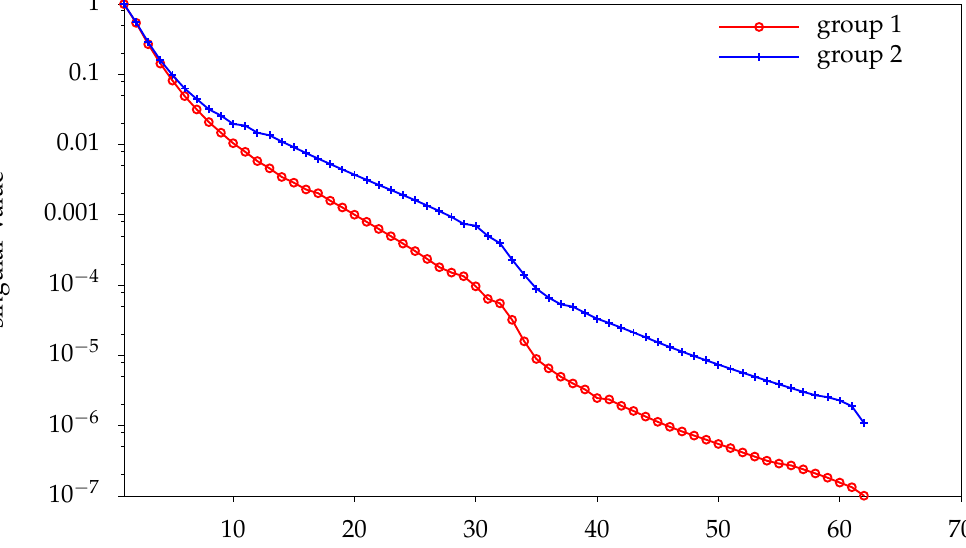
Figure 4. The singular values for groups 1 and 2 associated with the scalar flux solutions (snapshots) from global proper orthogonal decomposition (GPOD). The values have been normalised by the largest singular